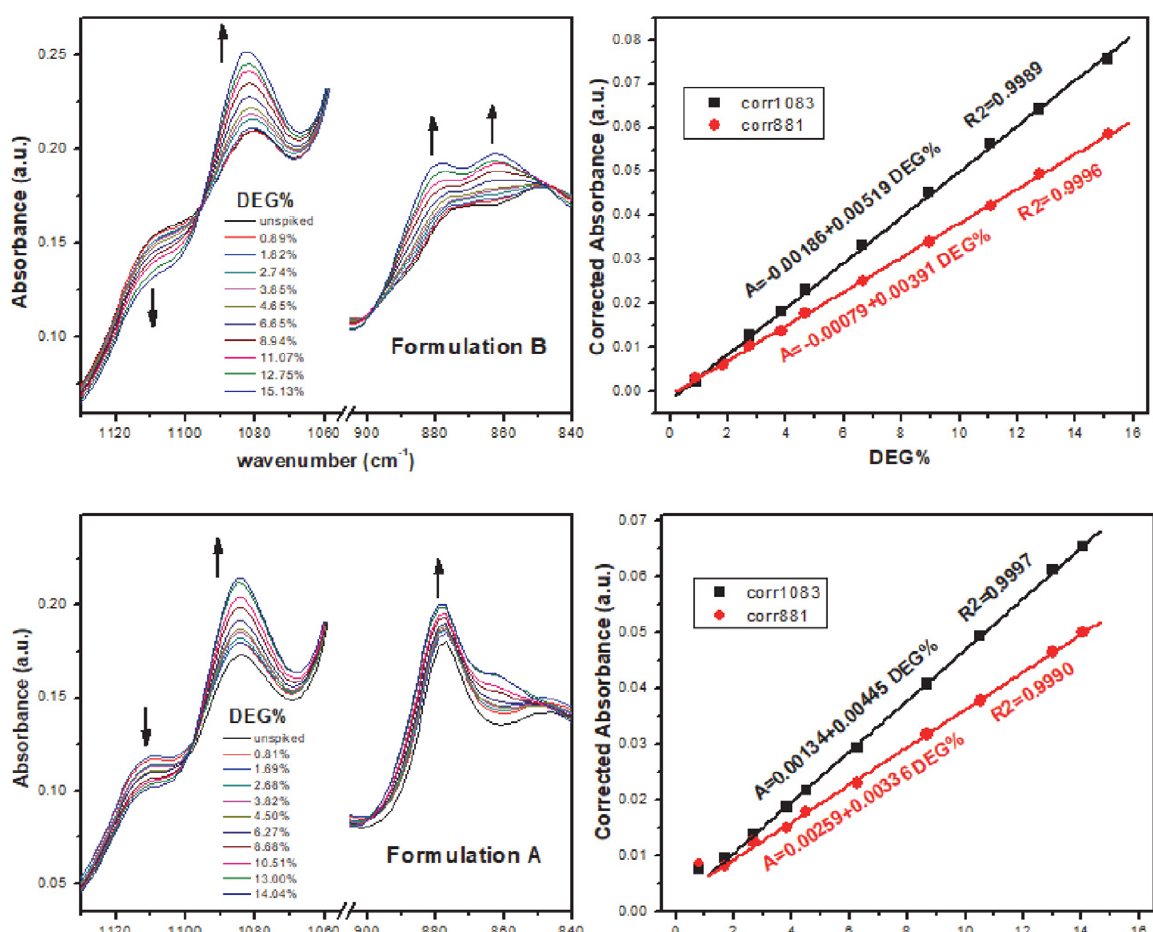
Figure 5: FT-IR spectra of paracetamol formulations (A and B) unspiked and spiked with different DEG% (left). Corrected DEG absorbance at 881 cm –1 and 1083 cm –1 versus its percentage in spiked samples of each formulation Table 3: Actual and predicted DEG percentages from corrected ab- sorbance at 1083 cm –1 of two formulations for paracetamol syrup Formulation A Formulation B